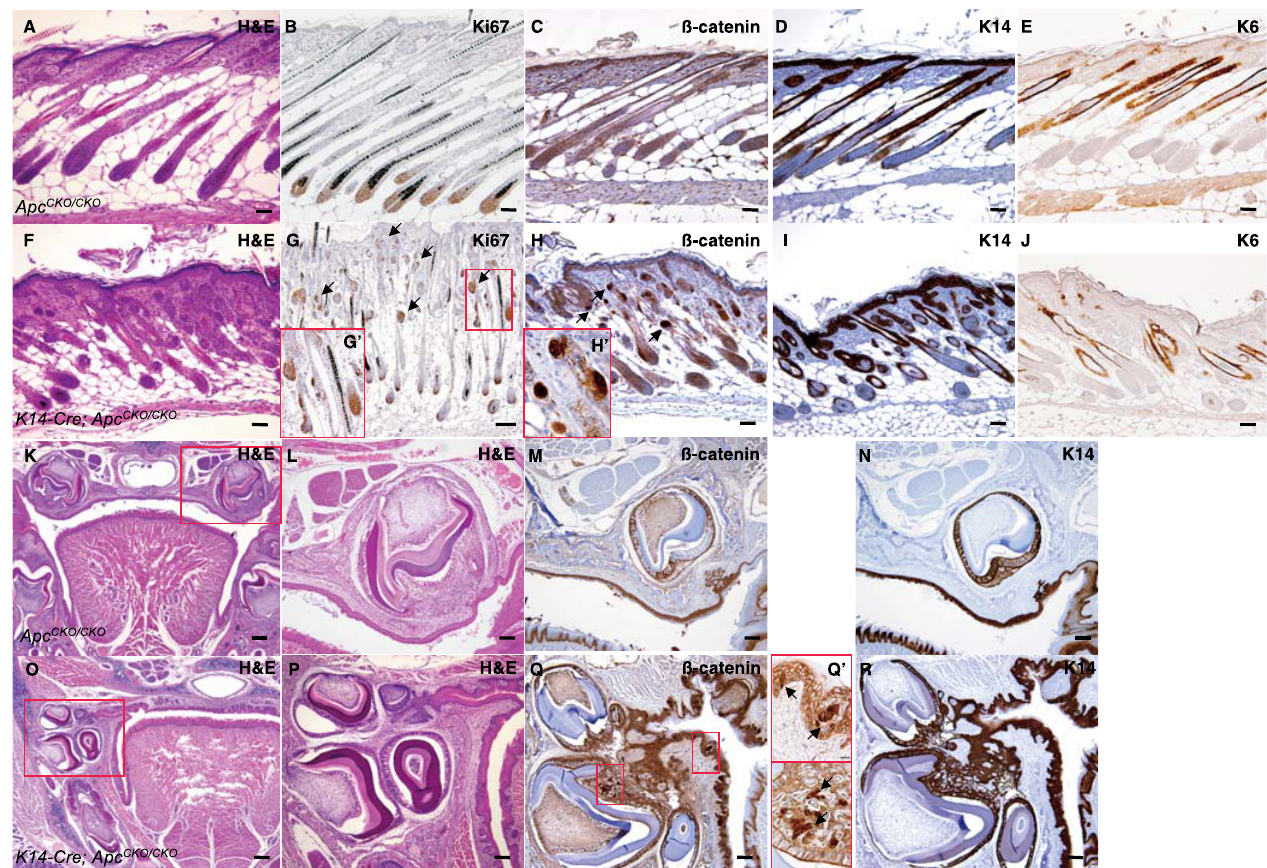
Figure 4. Histological and Immunochemical Examination of P12 Skin and Teeth (A–E) P12 normal skin. (F–J) P12 mutant skin. (K–N) P12 normal oral cavity. (O–R) P12 mutant oral cavity. Stained with H&E for histology (A, F, K–L, O–P), Ki67 (B, G), b -catenin (C, H, M, Q), K14 (D, I, N, R), and K6 (E, J). Aberrant follicular morphogenesis, characterized by formation of irregularly spaced, nonpolarized hair follicles, in mutant skin is evident. Despite the abnormal histology, proliferation seems to be confined to hair bulb-like structures (arrows in [G], inset [G 9 ] at higher magnification), but in mutant skin (arrows in [H], inset [H 9 ] at higher magnification) and oral cavity (arrows in